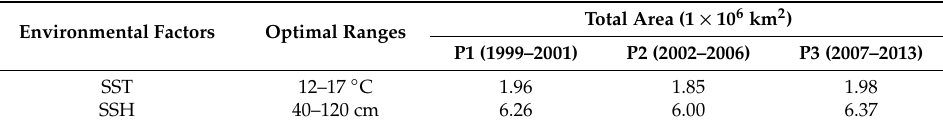
Table 4. Preferred ranges for SST and SSH derived from the multi-model habitat ensemble, with the corresponding total area falling within these optimal environmental conditions for the neon flying squid under PDO-specific periods. P1 (1999–2001) P2 (2002–2006) P3 (2007–2013)